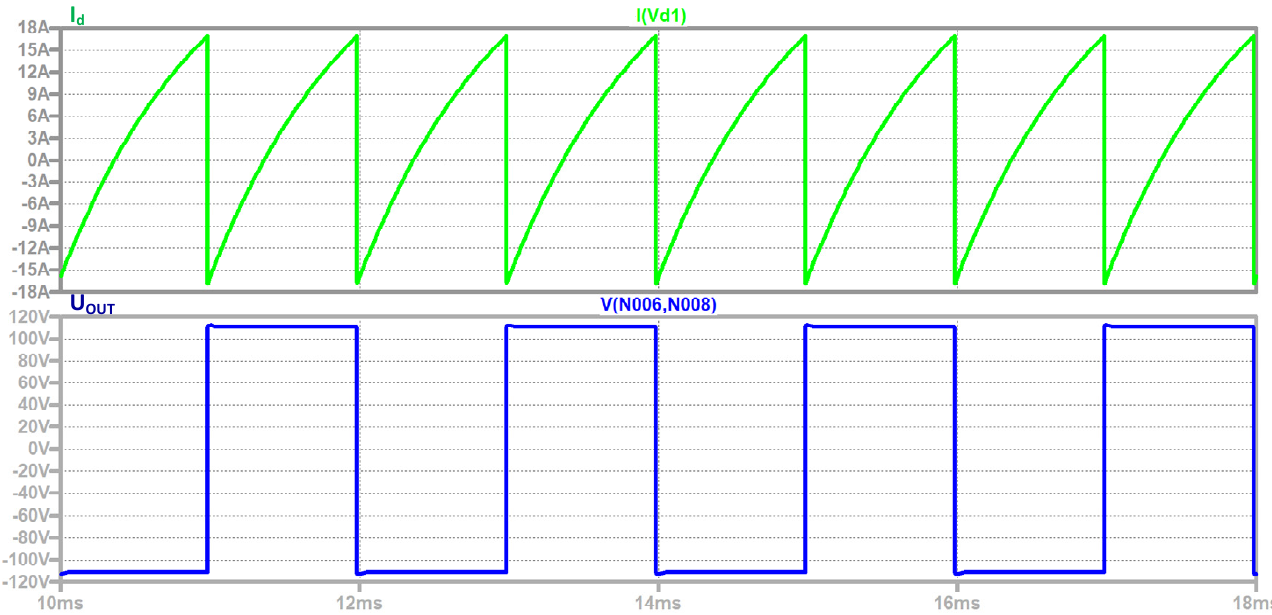
Figure 8. Time diagram of the input current—I d and output voltage—u OUT .